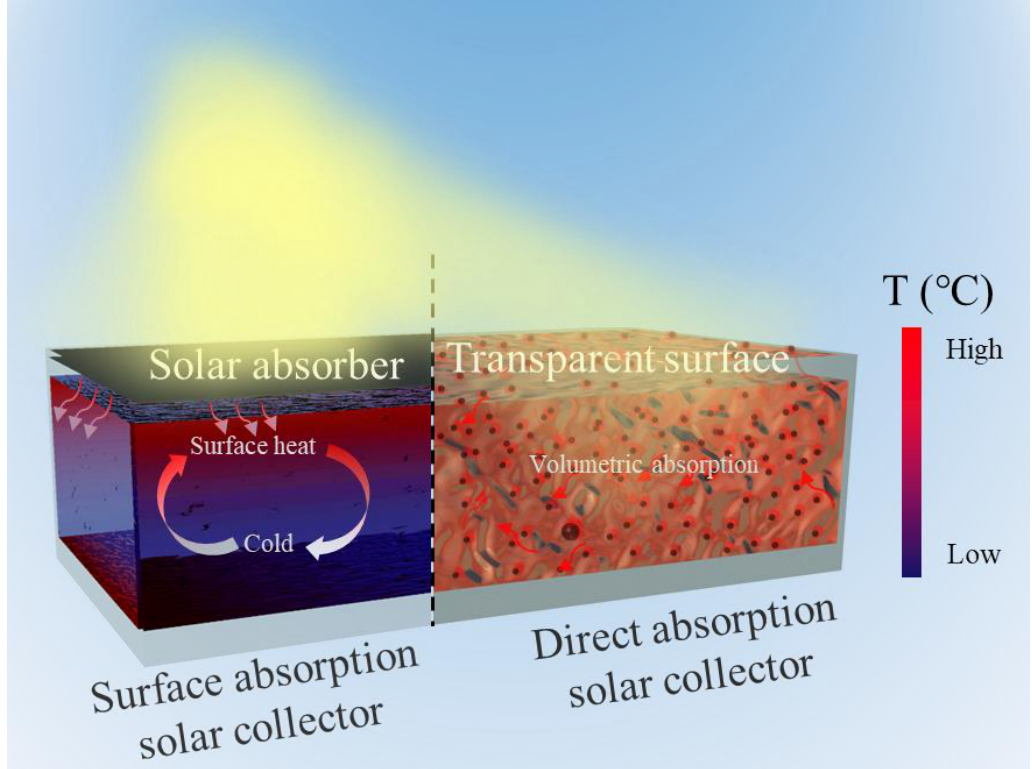
Figure 1. Schematic showing converting concentrated sunlight into medium-temperature heat by surface absorption-based solar collectors and direct absorption-based solar collectors.